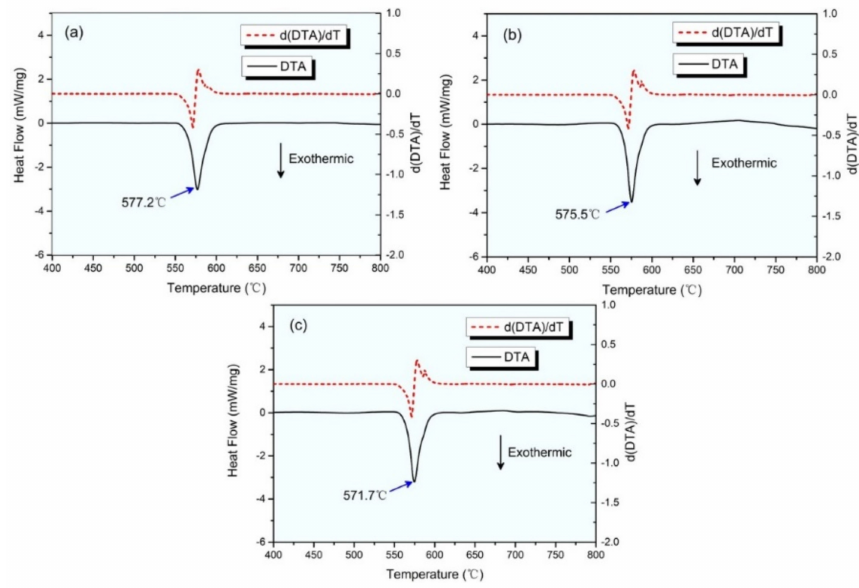
Figure 6. ( a – c ) DTA thermograph of C1 alloy, C2 alloy, and C3 alloy, respectively.